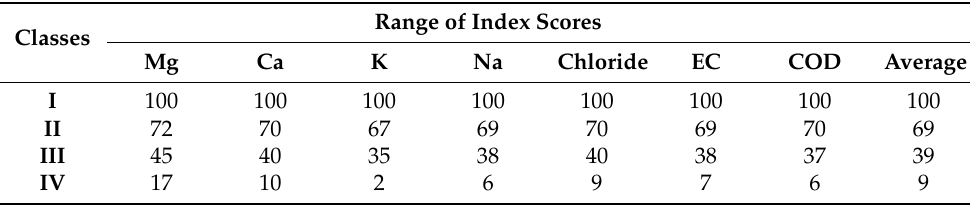
Table 11. Limit of the range of index scores for all